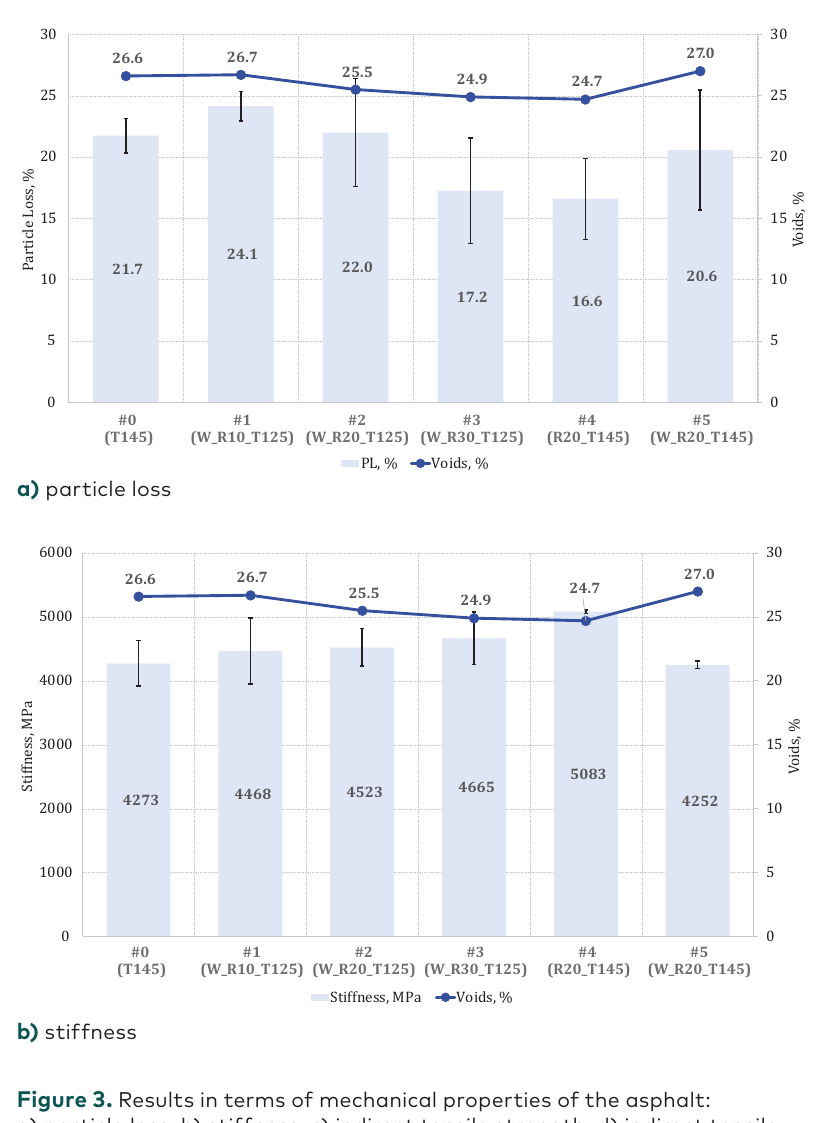
Figure 3. Results in terms of mechanical properties of the asphalt: a) particle loss, b) stiffness, c) indirect tensile strength, d) indirect tensile strength